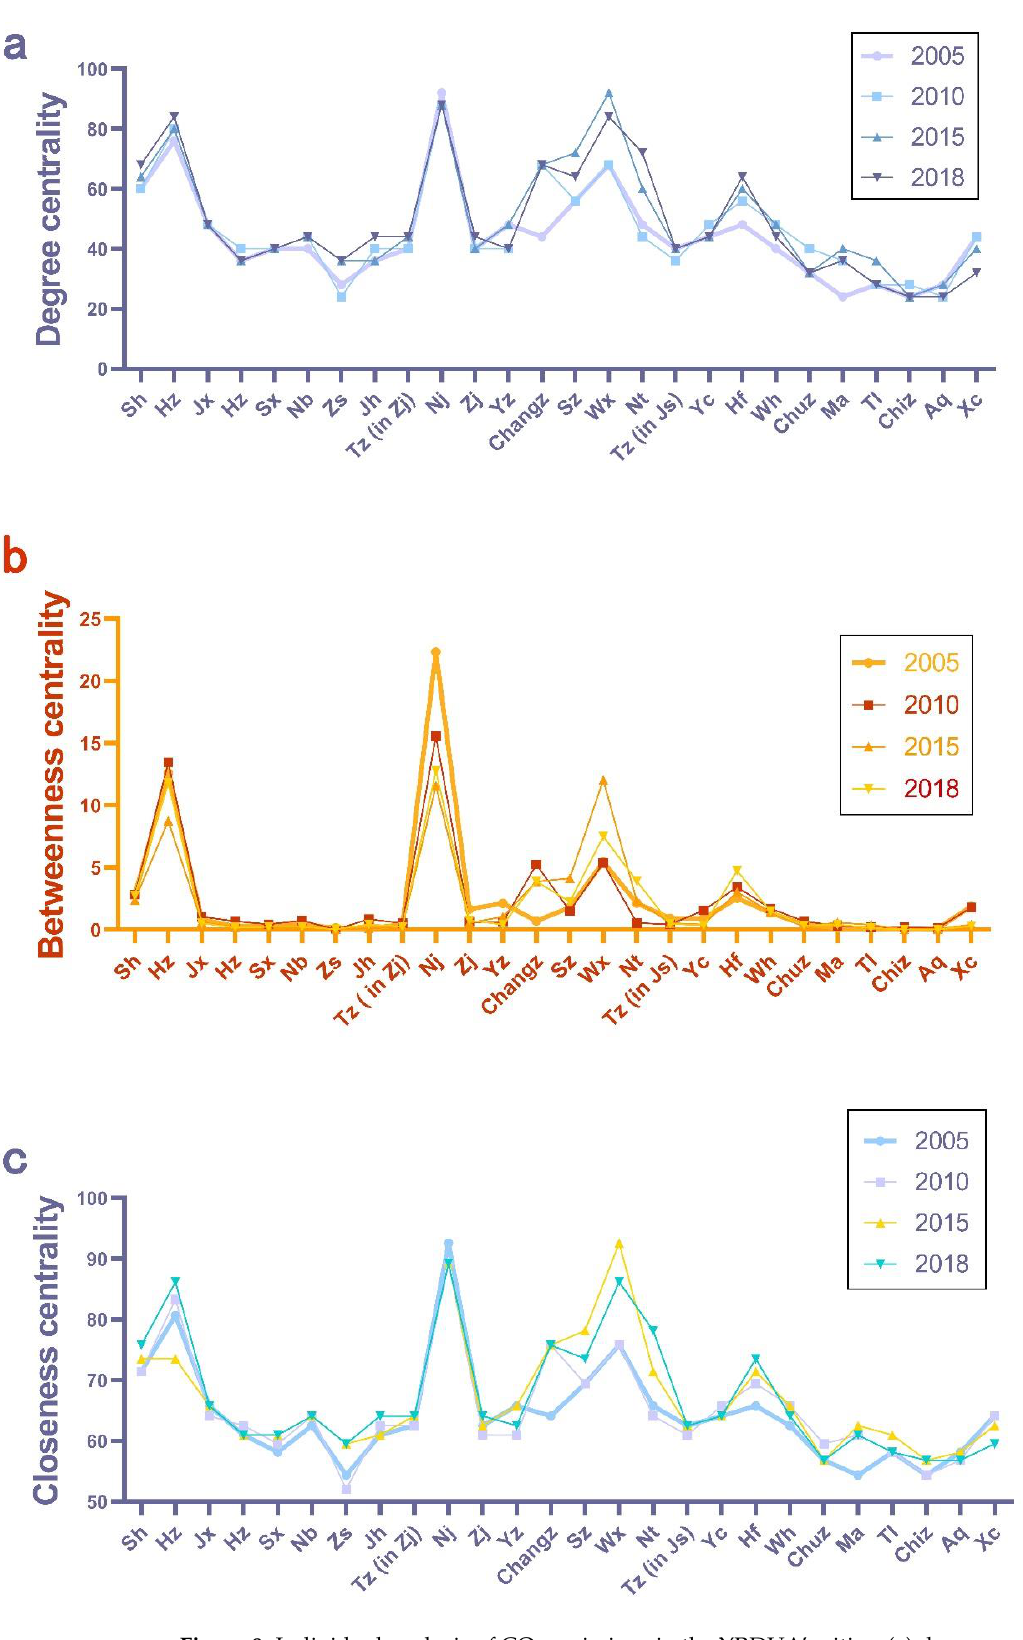
Figure 8. Individual analysis of CO 2 emissions in the YRDUA’s cities: ( a ) degree centrality; ( b ) betweenness centrality; ( c ) closeness centrality.